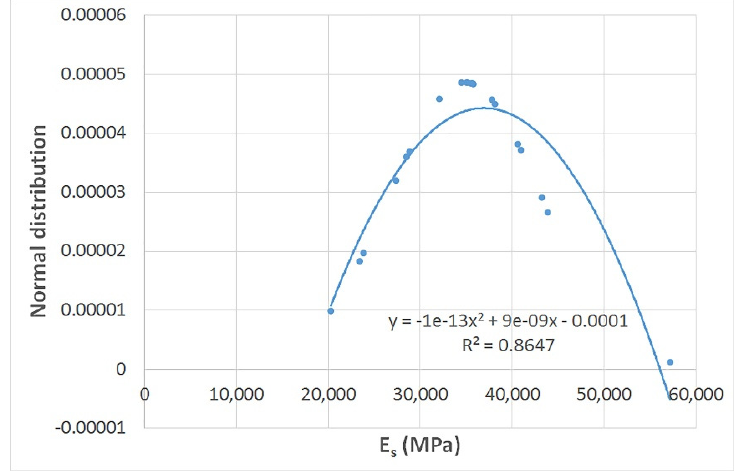
Figure 9. Gauss distribution of elastic secant modulus of stone cores.